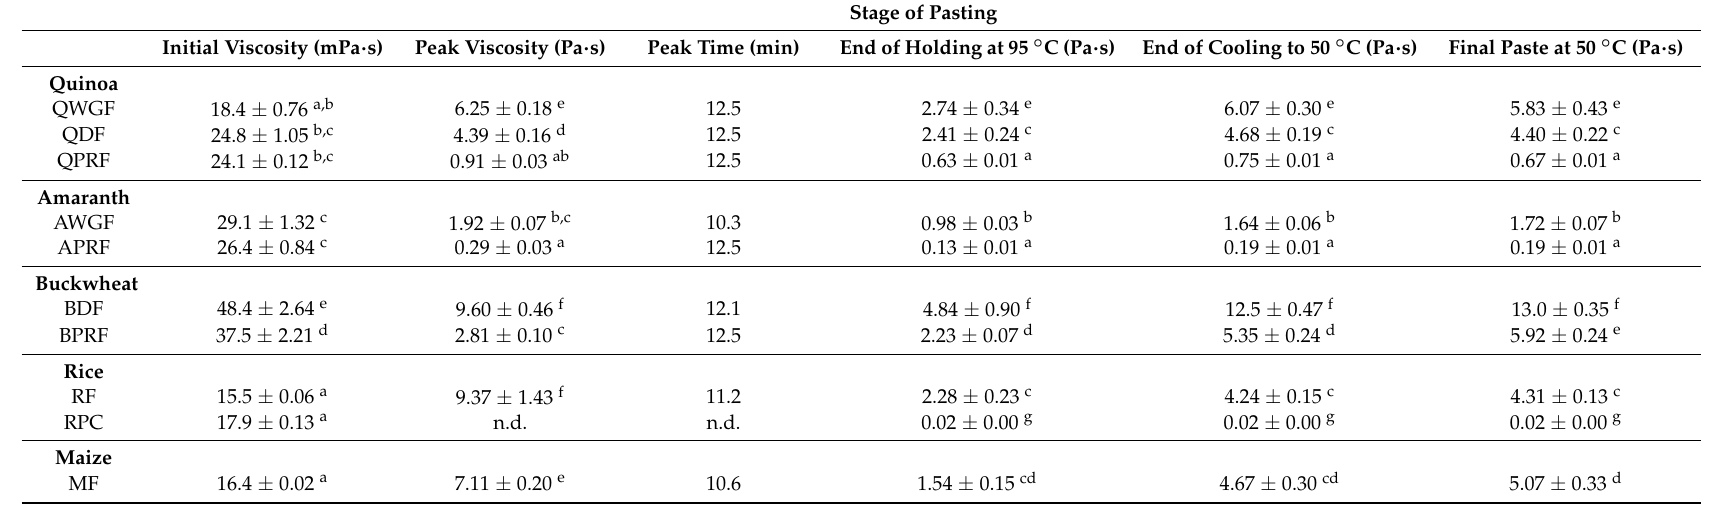
Table 2. Viscosity of quinoa wholegrain flour (QWGF), quinoa dehulled flour (QDF), quinoa protein-rich flour (QPRF), amaranth wholegrain flour (AWGF), amaranth protein-rich flour (APRF), buckwheat dehulled flour (BDF), buckwheat protein-rich flour (BPRF), rice flour (RF), rice protein concentrate (RPC), and maize flour (MF) dispersions at various stages of the pasting regime. Values are means ± standard deviations of data from triplicate